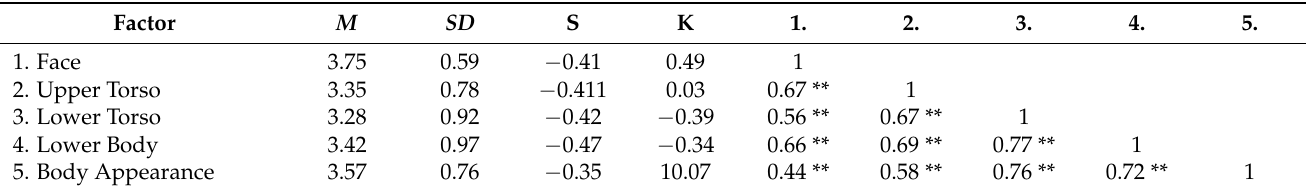
Table 4. Descriptive statistics and